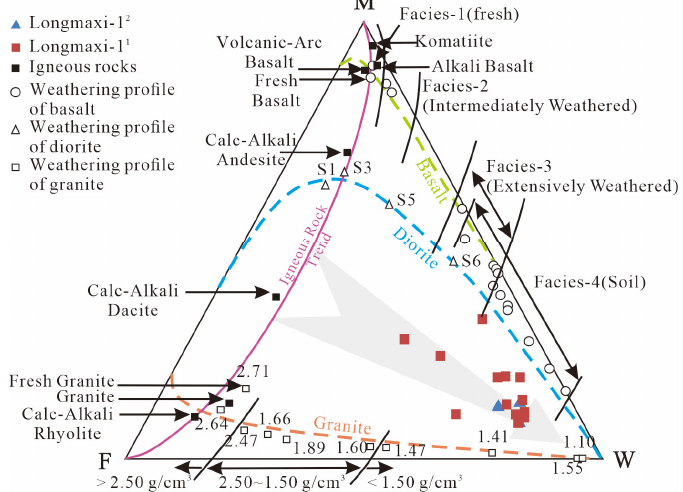
Figure 6. WFM discriminant diagram in Longmaxi-1 black shales [58]. M, F, and W represent the mafic source, felsic source, and weathered material, respectively. The broken lines are linear compositional trends for igneous, diorite, and granite weathering profiles.